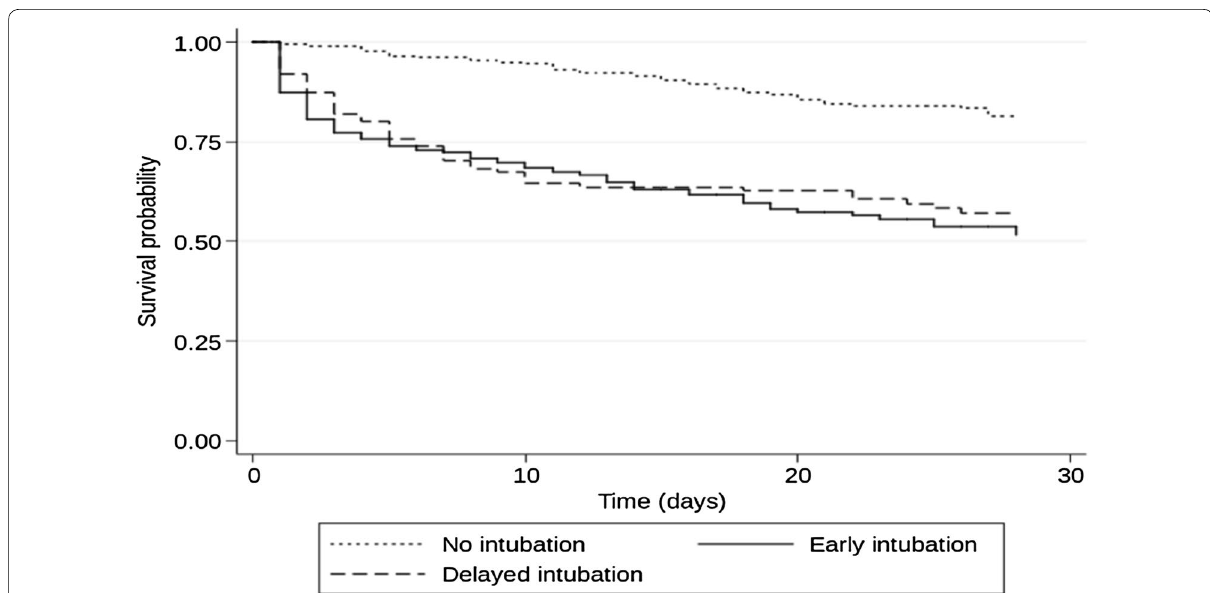
Fig. 4 28‑day survival according to intubation status. P comparisons between patients intubated early vs. never